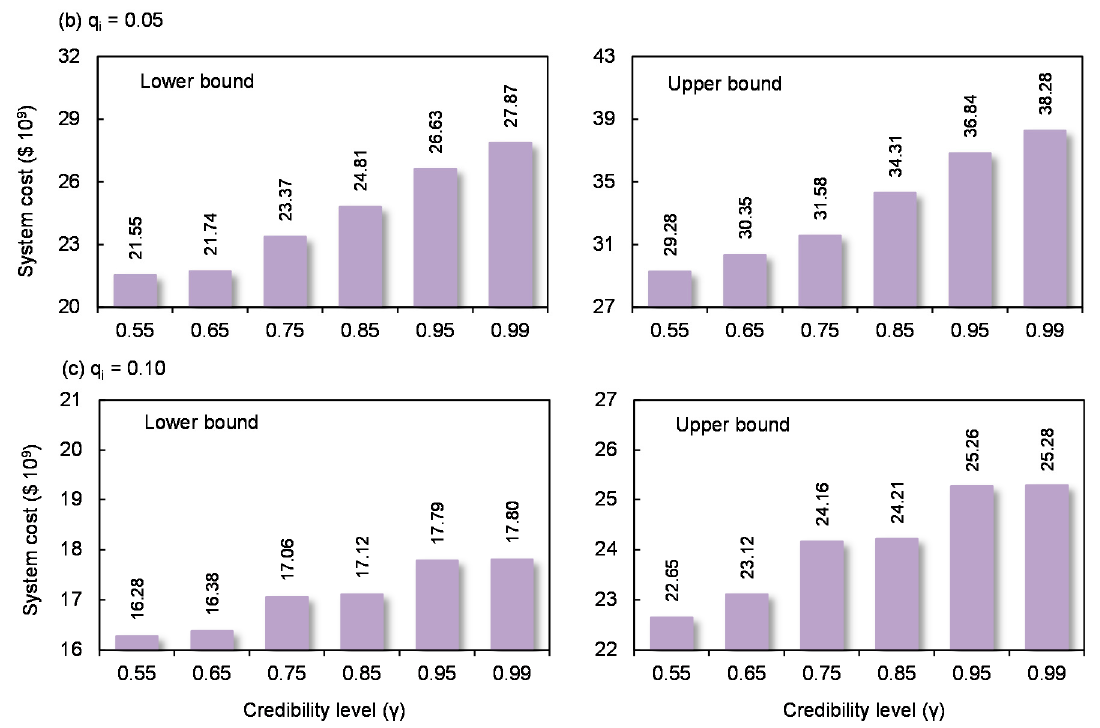
q level and γ level. ( a ) Figure 2. System cost under each Figure 2. System cost under each q i level and γ level. ( a ) q i = 0.01; ( b ) q i = 0.05; ( c ) q i = i